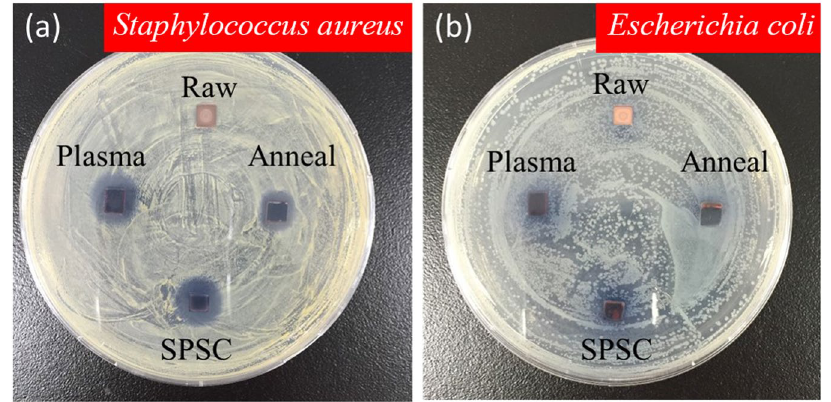
Figure 10. Antimicrobial activity test. Photos after culture with ( a ) Gram-positive ( Staphylococcus aureus ) bacteria and ( b ) Gram-negative ( Escherichia coli K12) bacteria in agar in a Petri dish for 24 hours at 37 °C. The samples are raw (as-received Cu plate), plasma-treated, SPSC-UV48 h and annealed